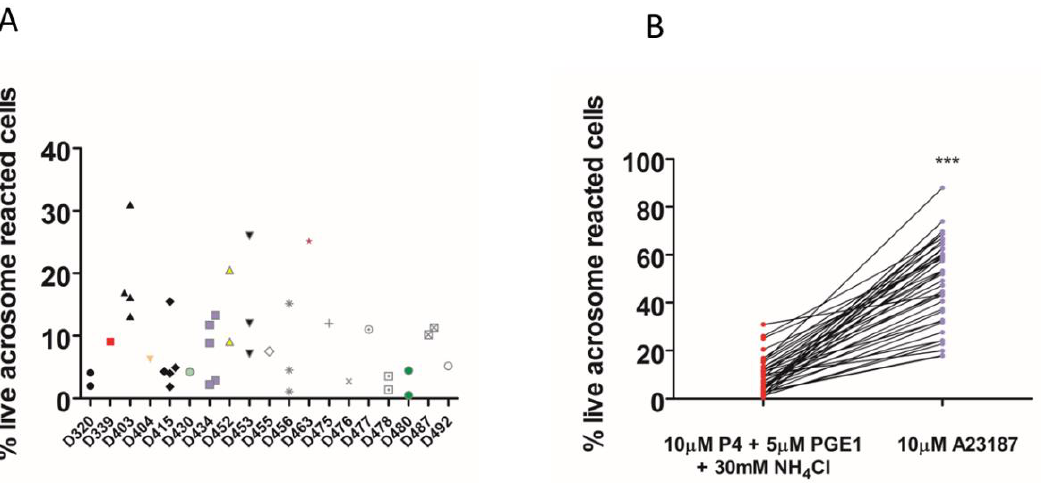
Figure 5. Intra-donor heterogeneity of acrosome reaction (AR) triggered by P4/PGE1/NH 4 Cl. ( A ). Scatter plot showing the variability of AR in 39 samples from 19 donors. ( B ). Paired data from the same experiments showing the response to ionophore relative to P4/PGE1/NH 4 Cl. Mean data are significantly different. *** p <